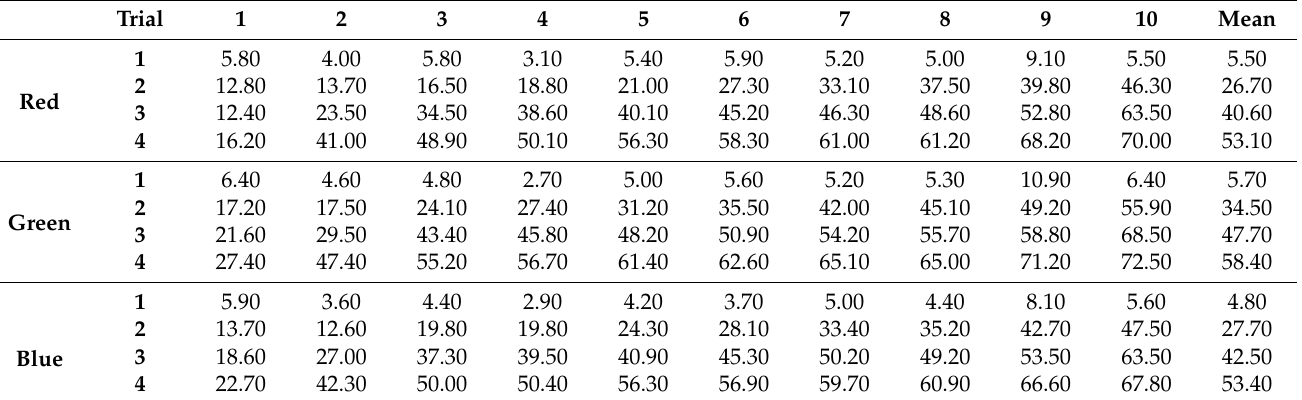
Table A1. Density intersection difference results for all trial histograms delineated by color channel using day-0 control images specific to each trial. The table heading denotes the day of treatment that was compared to the day-0 control for each individual trial. The side of the table denotes trial number as detailed in Table 1. Here, the scaled values are presented as percentages of change in comparison to the control.